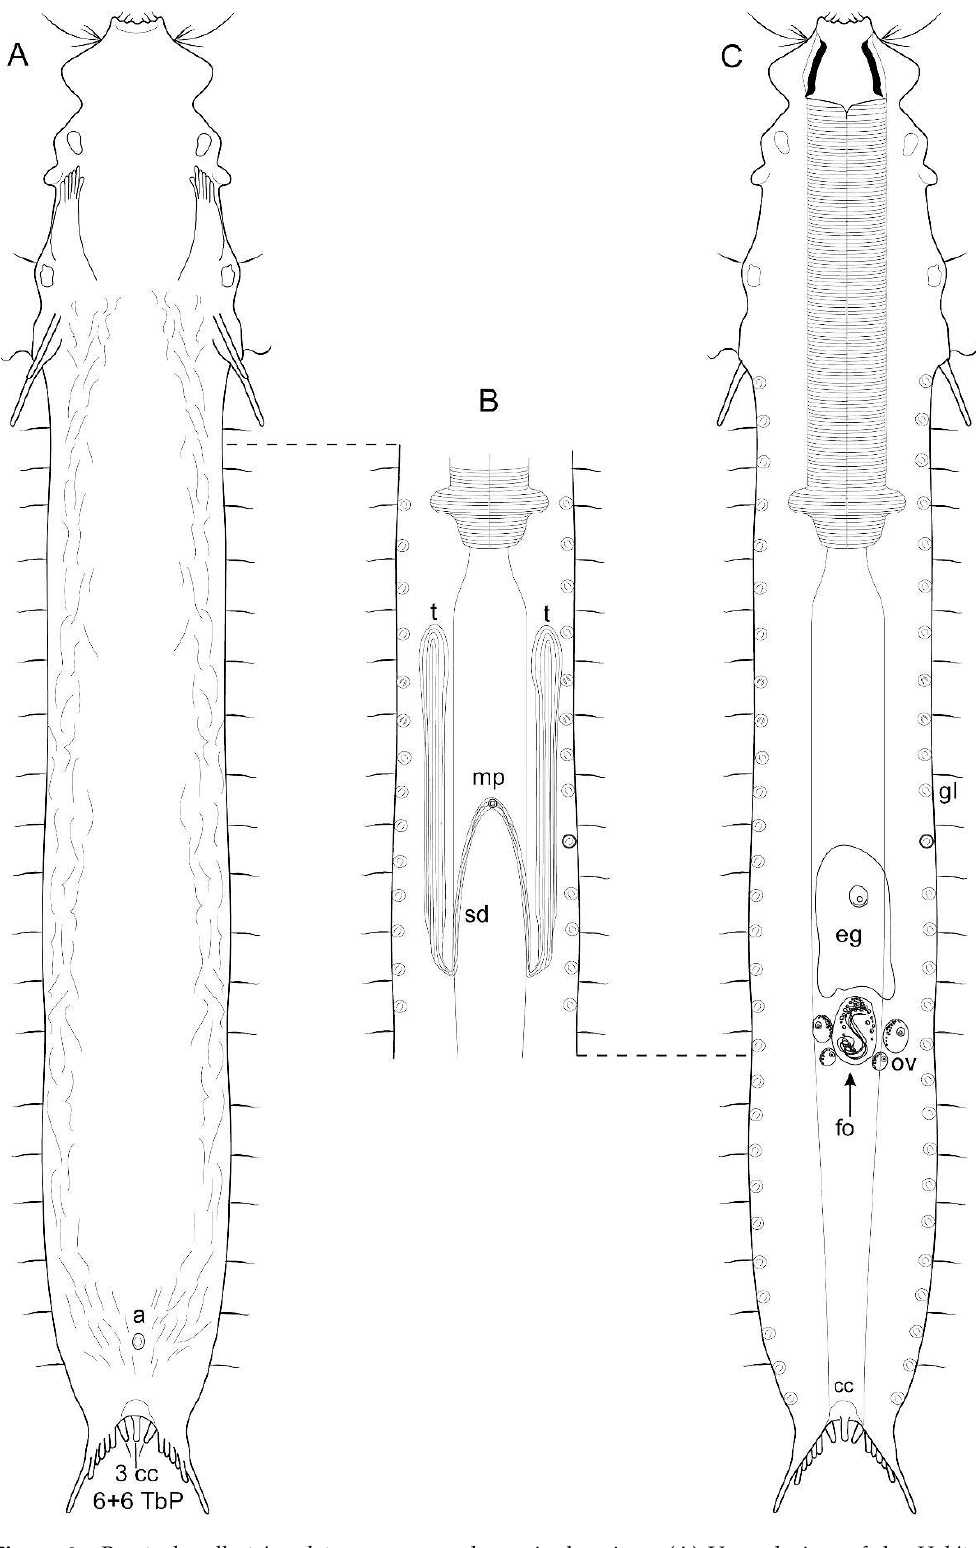
Figure 2. Paraturbanella tricaudata sp. nov. schematic drawing. ( A ) Ventral view of the Habitus. ( B ) Detail of the mid-trunk region, showing a ventral view of the male system. ( C ) Dorsal view of the Habitus, showing a mature egg, the frontal organ and the ovaries. Abbreviations: a = anus, fo = frontal organ, gl = gland, mp = male pore, ov = ovary, sd = sperm duct, and t = testes.